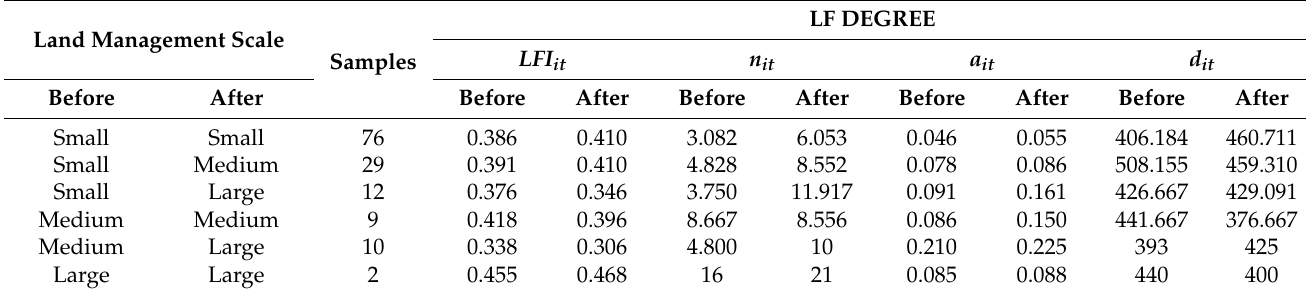
Figure 3. Relationship between scale of land management and degree of LF: ( a ) before transfer; ( b ) after transfer. To further reveal the relationship between the scale of land management and the degree of LF, the group average clustering method was used to divide the rice farmers into three groups: small-scale farmers (<0.5 hectares), medium-scale farmers (0.5–1 hectares), and large-scale farmers ( ≥ 1 hectare). As shown in Table 5, before land transfer, the large-scale farmers had the highest LFI, followed by the small-scale farmers, then by the medium-scale farmers. After land transfer, the small-scale farmers had the highest LFI, followed by the medium-scale farmers, then by the large-scale farmers. These results are consistent with the findings in Figure 3. However, when the small- and medium-scale farmers transformed into large-scale farmers, the LFI was significantly reduced, indicating that rice farmers paid close attention to the reduction of LF in the pursuit of moderate scales of operation. Table 5. Relationship between scale of land management and degree of